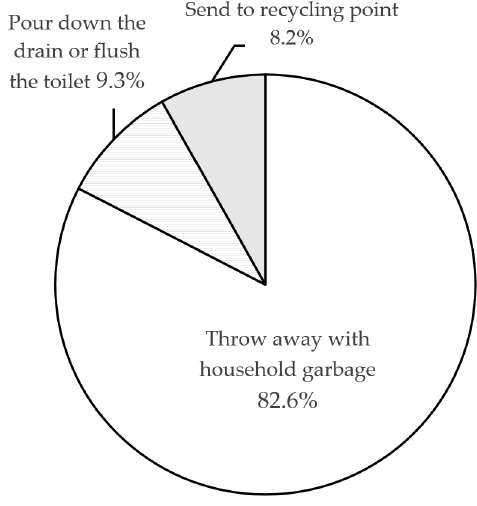
Figure 9. Methods of expired drug disposal.